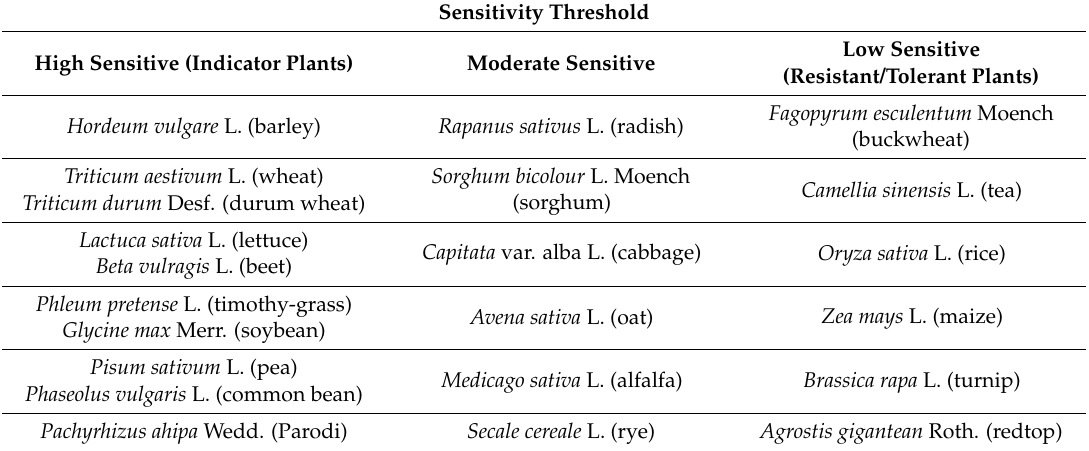
Table 3. Sensitivity of plants to aluminum toxicity, modified from